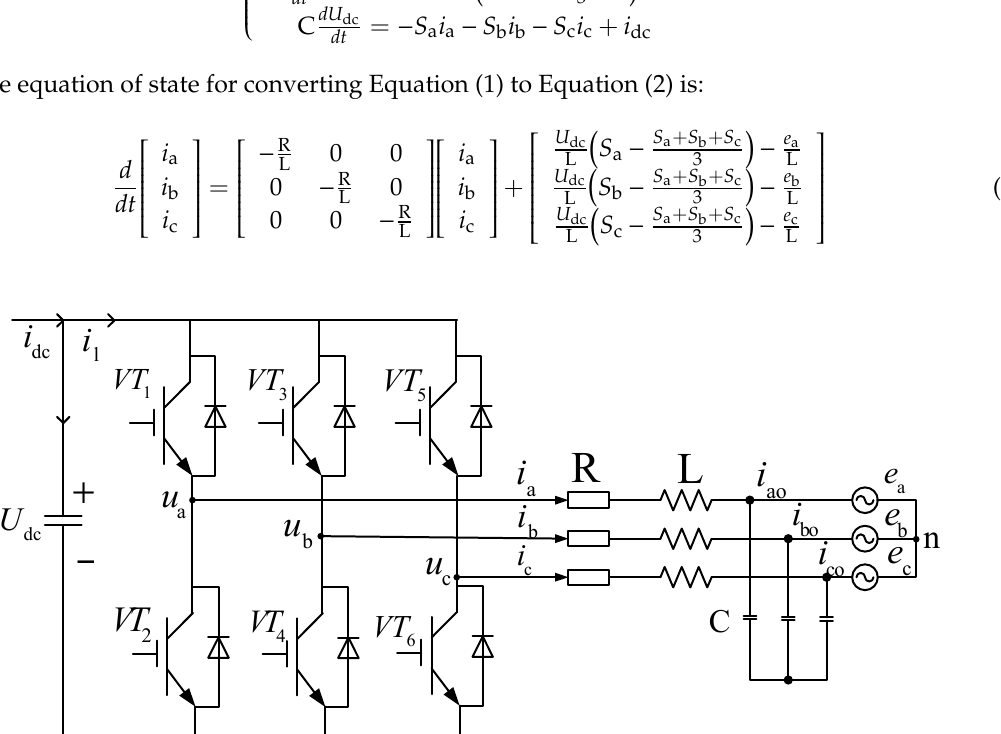
Figure 1. Circuit topology of three-phase voltage type PWM wind power grid-connected inverter.